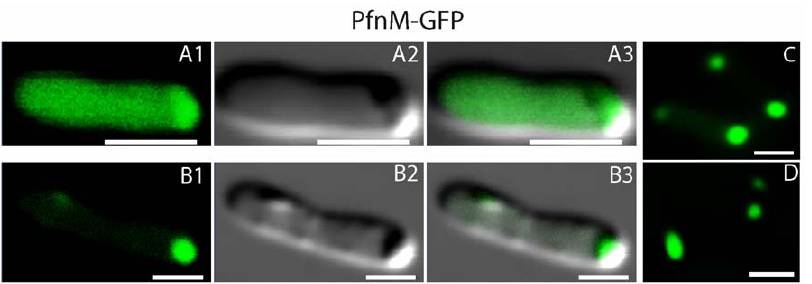
Figure 2. PfnM-GFP expression in E.coli. In E.coli , PfnM-GFP distributes evenly in the cytoplasm (A1-3) or is localized to the cell poles (B1-D). Scale bars: 2 m m.